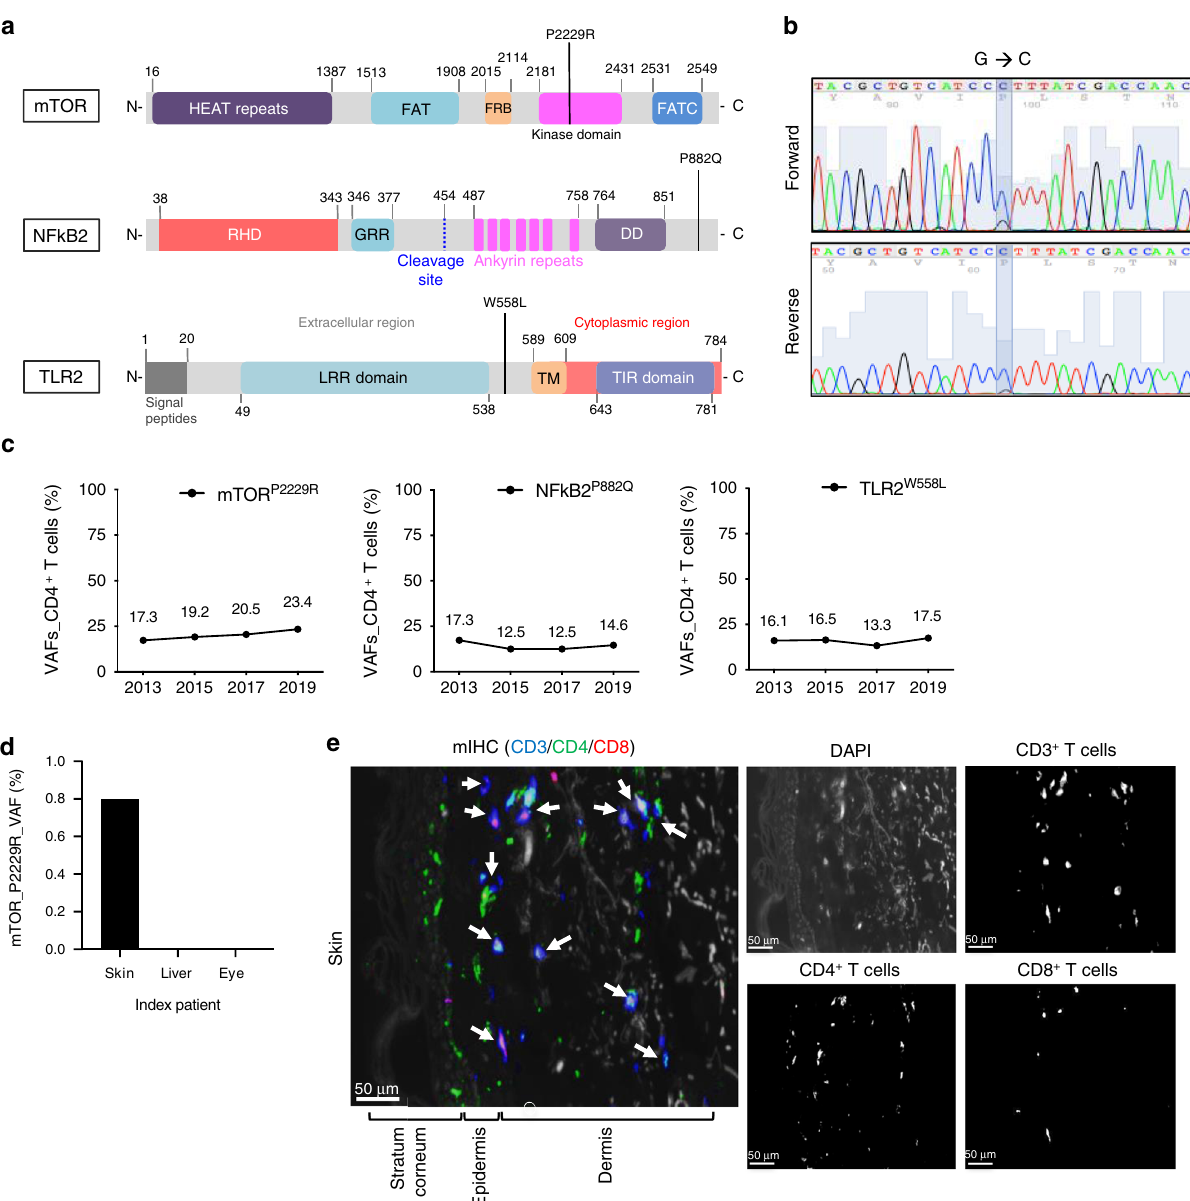
Fig. 2 mTOR, NF κ B2 , and TLR2 mutations in index patient. a Locations of mTOR, TLR2 , and NF κ B2 somatic mutations. Linearized structure of MTOR, NF κ B2 , and TLR2 presenting the location of somatic mutations. mTOR P2229R mutation is located in the kinase domain, NF κ B2 P882Q in the C-terminus, and TLR2 W558L between LRR (Leucine-rich repeats) domain and transmembrane (TM) domain. b A heterozygous mTOR mutation (G to C, P2229R ) was detected in CD4 + T cells by Sanger sequencing. c Variant allele frequencies (VAFs) of mTOR P2229R , NF κ B2 P882Q , and TLR2 W558L mutations in the index patient ’ s CD4 + T cells over time as measured with amplicon sequencing. Source data are provided as a Source data fi le. d VAFs (%) of mTOR P2229R mutation from the index patient ’ s skin, liver, and eyes biopsy. e Immuno fl uorescence staining indicated CD3 + CD4 + and CD3 + CD8 + T cell in fi ltration in the skin. Paraf fi n embedded skin biopsy from the index patient was sectioned and stained with antibody speci fi c human CD3 (cyan), CD4 (green), and CD8 (red). White arrows indicate in fi ltrated CD3 + CD4 + or CD3 + CD8 + T cells. Original imaging magni fi cation: 20×, the fi gure has been further zoomed to 25× for visualization. Scale bar: 50 μ